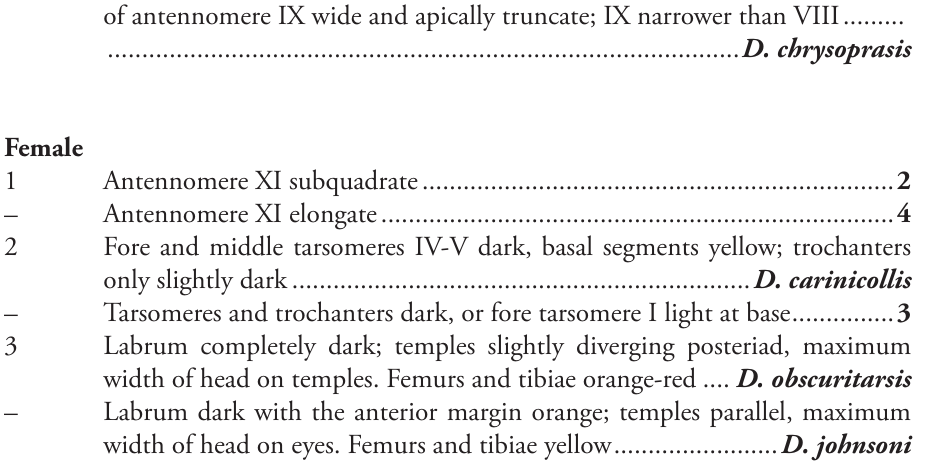
Frontal calli with a dorsal keel anteriorly protruded and pointed; fore tibiae Frontal calli neither keeled nor anteriorly protruding; fore tibiae simple or with a laminar expansion, at least on the external side ............................... 7 6 Antennomeres VIII-XI with black lines and spots, distal half of X wide, ca twice as wide as that of IX, VII obliquely truncate at apex, incision of distal – Antennomeres VIII-XI without black lines and spots, distal half of X narrow, as wide as that of IX, VII bilobed at apex, incision of distal portion of IV Fore tibiae simple. Antennomere X only 1/3 as wide as the length of XI ....... Fore tibiae greatly modified. Antennomere X wider than 1/3 the length of XI.... 8 Antennomere X about as wide as the length of XI, anterior portion slender – Antennomere X distinctly narrower than the length of XI. Anterior portion of antennomere IX wide and apically truncate; IX narrower than VIII .........